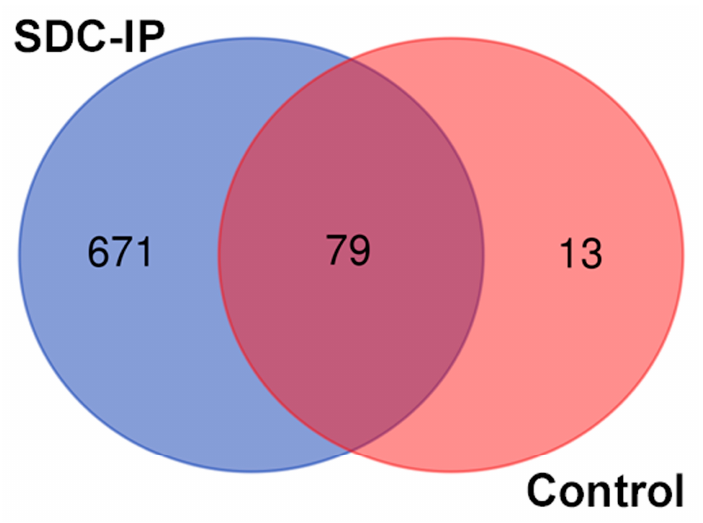
Figure 1. Venn diagram representing overlap between SDC1 co-precipitating proteins and control sample (precipitate obtained with mouse IgG but without the addition of the CD138